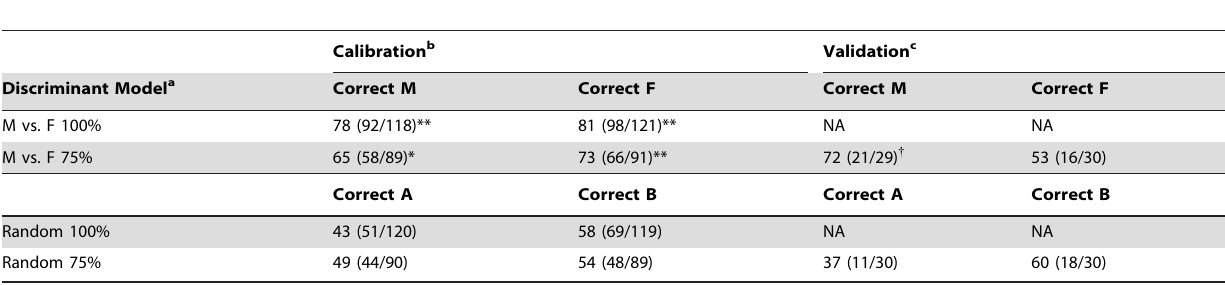
Table 2. Application of near infrared spectroscopy of feces to discriminate between adult male and female captive giant pandas ( Ailuropoda melanoleuca ) housed in US zoos.